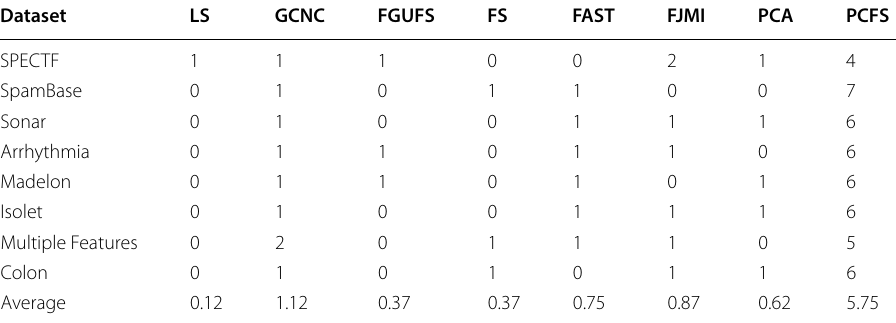
Table 6 Average number of selected features in ten independent run Data Set PCFS SPECTF SpamBase Sonar